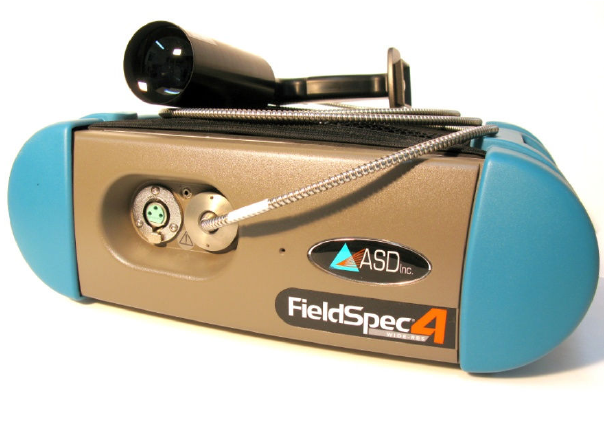
Figure 2. ASD FieldSpec4 Wide-Res spectroradiometer